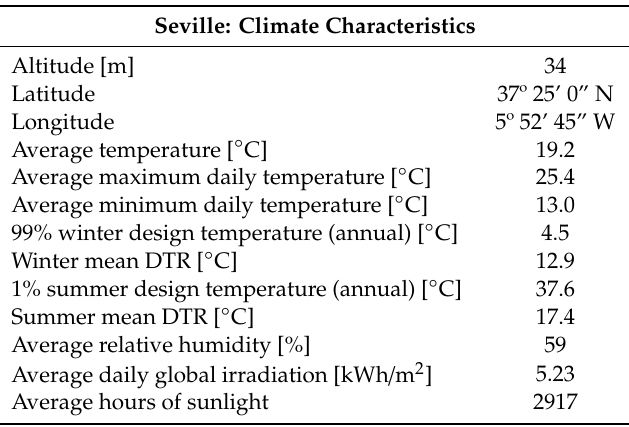
Table 1. Annual standard climate values, period 1981–2010